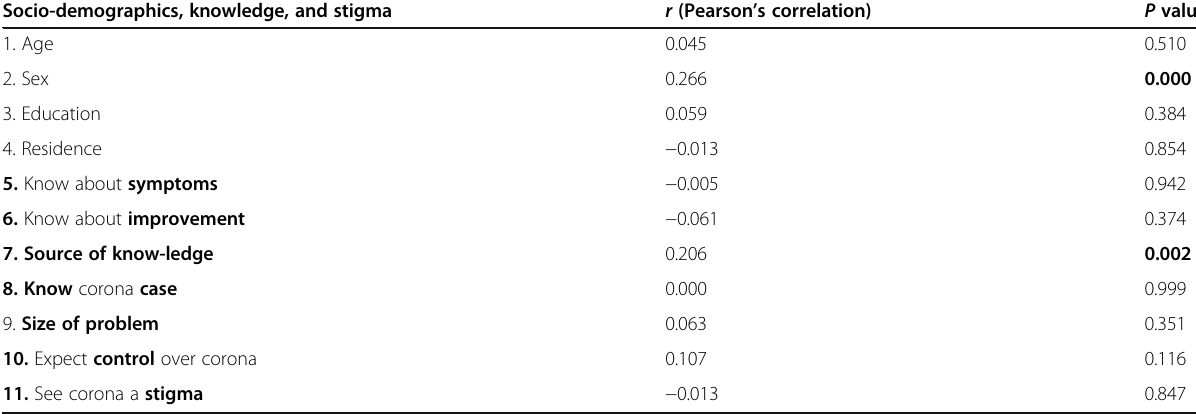
Table 3 Correlations of socio-demographics, knowledge, and stigma to score of anxiety on (GAD7) Socio-demographics, knowledge, and stigma r (Pearson ’ s